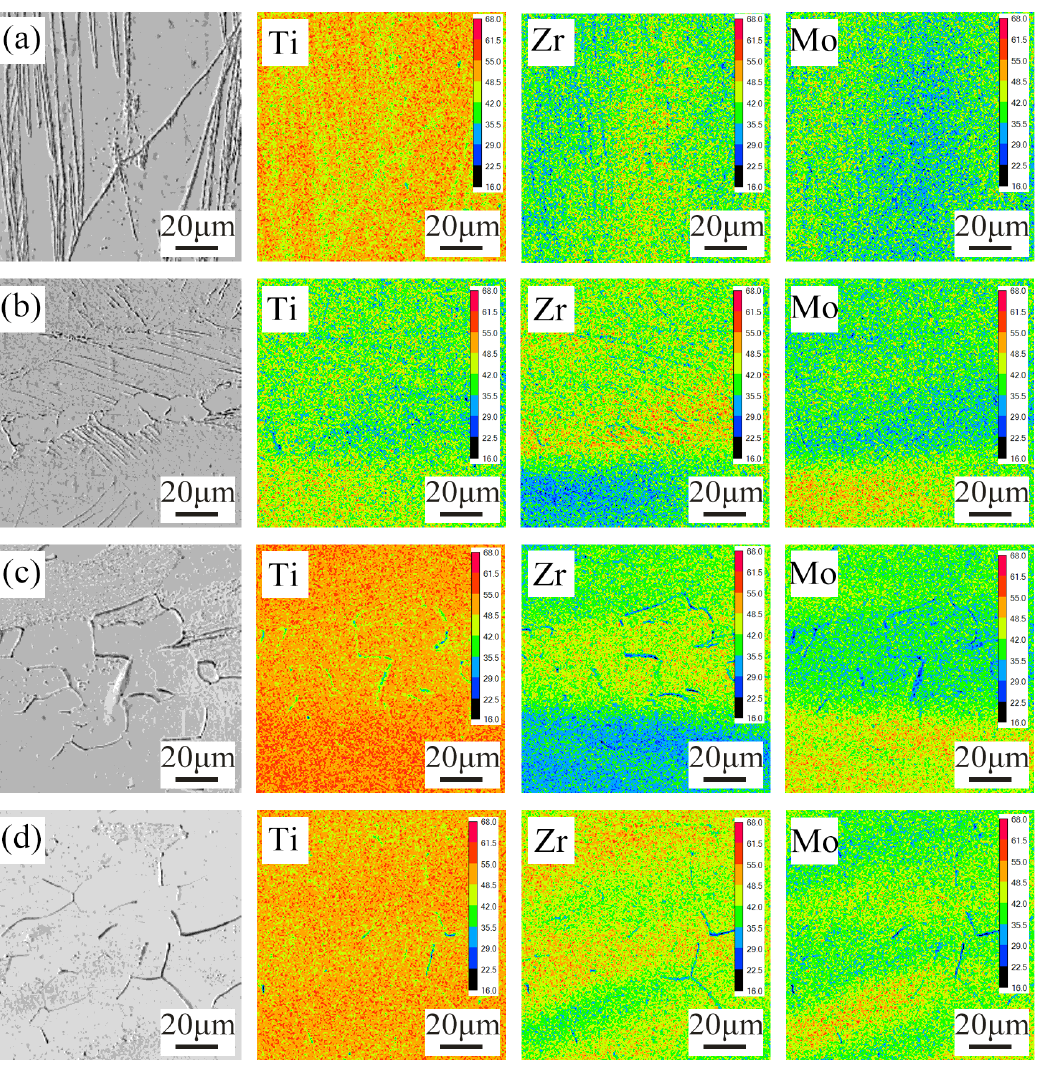
Figure 3. EPMA images of Ti-20Zr-15Mo alloys annealed at different temperatures: ( a ) 500 °C; ( b ) 600 °C; ( c ) 700 °C; ( d ) 800 °C.